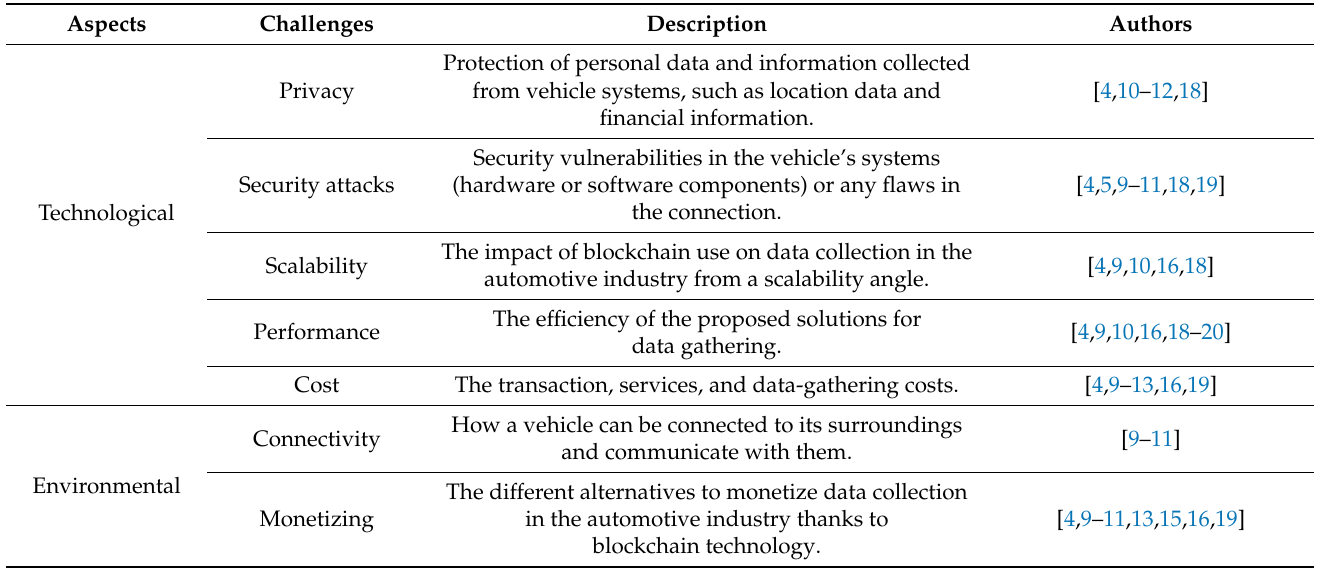
Table 2. Categories of reviewed